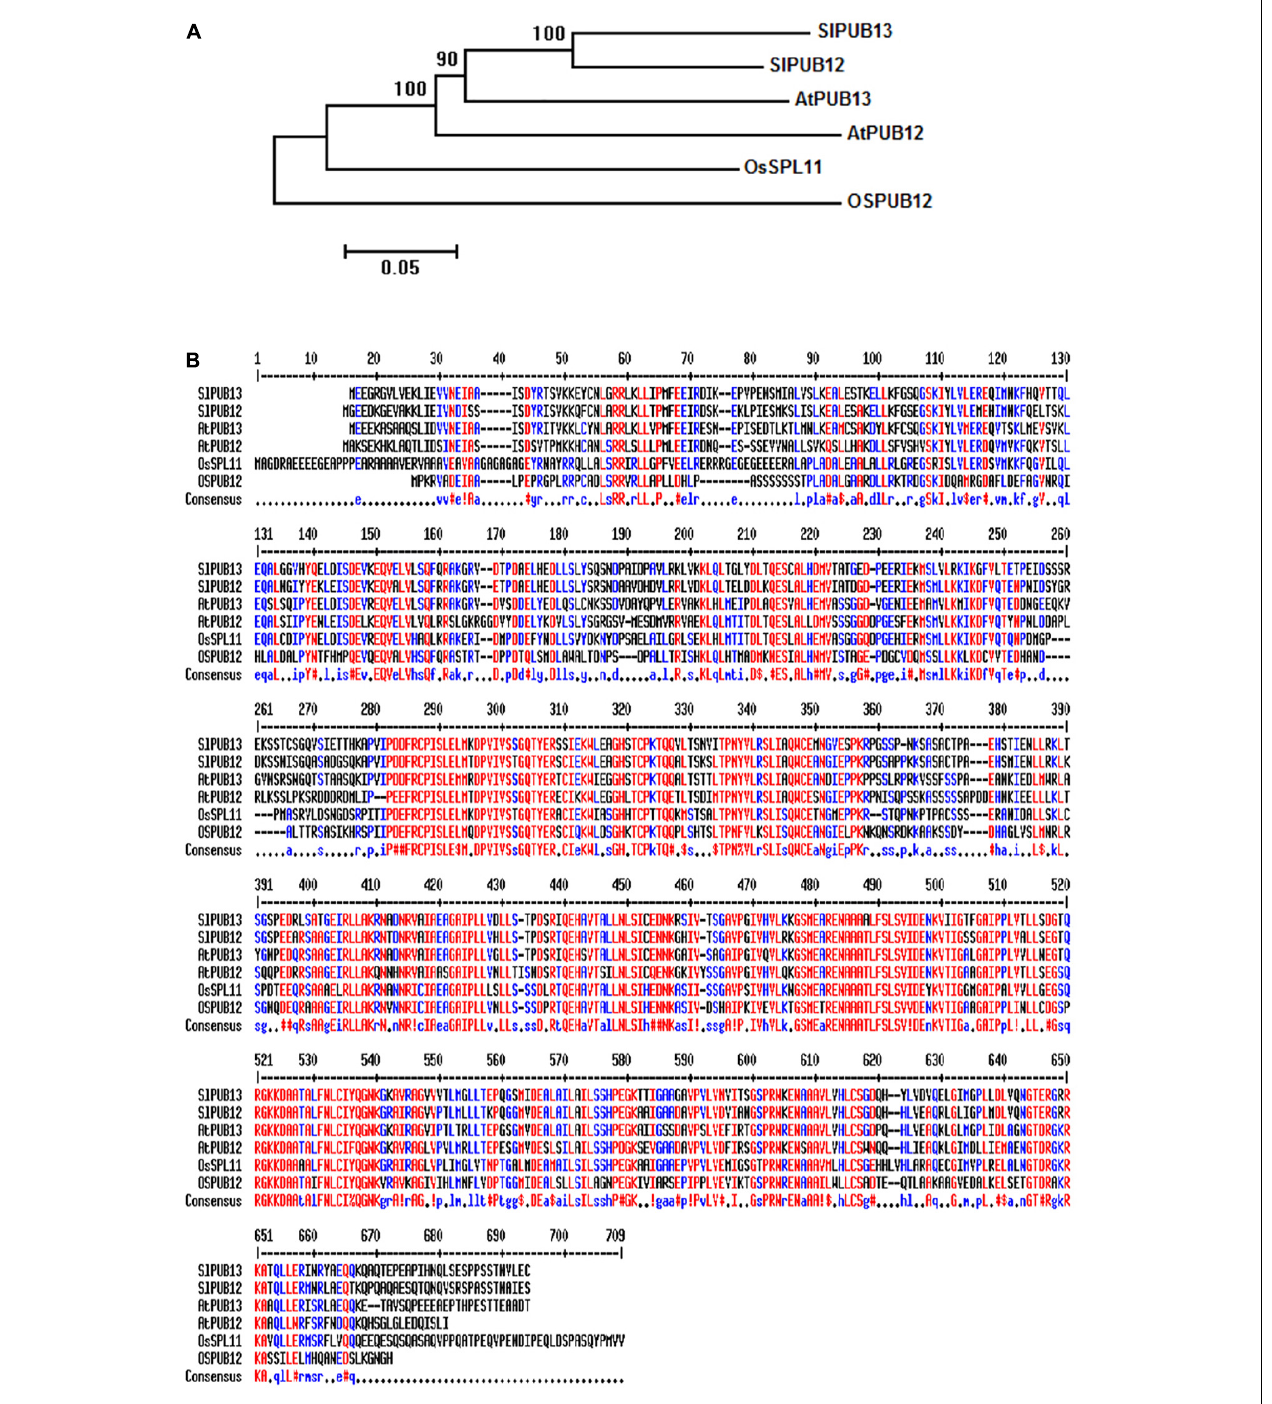
FIGURE 1 | Phylogenetic analysis and sequence alignments of PUB12 and PUB13 homologs from tomato, Arabidopsis and rice. (A) Phylogenetic analysis of PUB12 and PUB13 from tomato, Arabidopsis and rice. The sequences of PUB12 and PUB13 proteins were used for generating the tree. The unrooted phylogenetic tree was generated by the neighbor-joining method using the MEGA6 program with 1000 bootstrap trials (Saitou and Nei, 1987; Tamura et al., 2013). (B) Sequence alignments of PUB12 and PUB13 from tomato, Arabidopsis and rice. The sequences of PUB12 and PUB13 proteins in the FASTA format were entered into MultAlin and aligned using the default parameters (Corpet, 1988). Color red denotes high consensus amino acids while blue and black denotes low and neutral consensus ones, respectively.